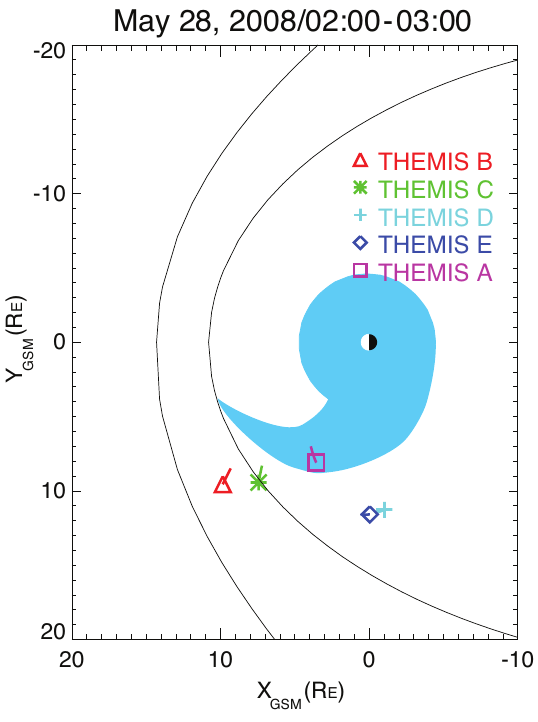
Fig. 5. A cartoon illustrating a plasmaspheric plume observed by THEMIS A (but not observed by THEMIS D and E ) in the mid- afternoon